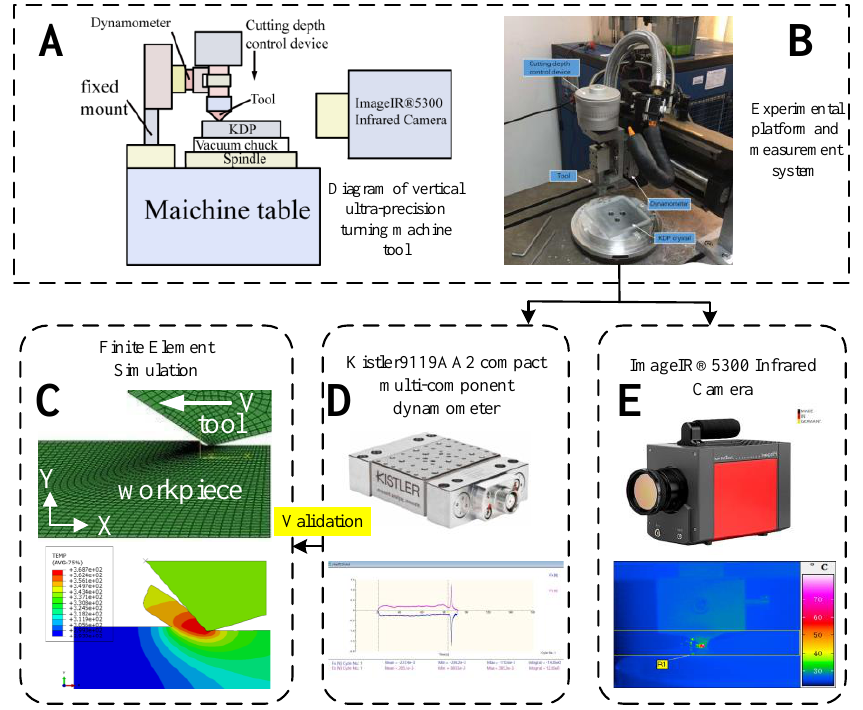
Figure 4. Experimental platform and measurement system: ( A ) Diagram of vertical ultra-precision turning machine tool; ( B ) Experimental platform and measurement system; ( C ) Finite Element Simulation; ( D ) Kistler9119AA2 compact multi-component dynamometer; ( E ) ImageIR ® 5300 Infrared Camera.